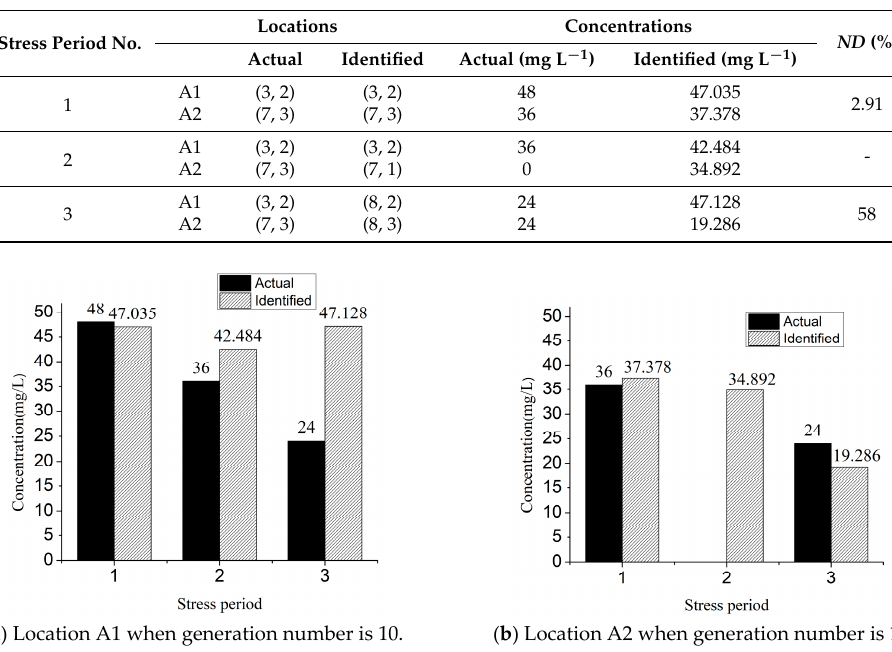
Figure 11. Identified results of A1 ( a ) and A2 ( b ) when generation number is 10.